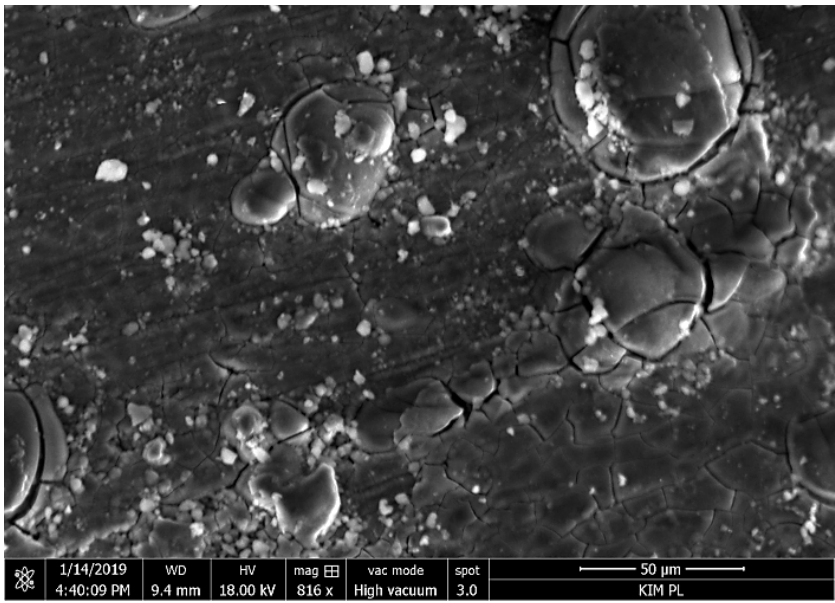
Figure 8 . Microstructure of the sol–gel coating after 150 h of soaking in 0.5 M NaCl; SEM. Figure 8. Microstructure of the sol–gel coating after 150 h of soaking in 0.5 M NaCl;